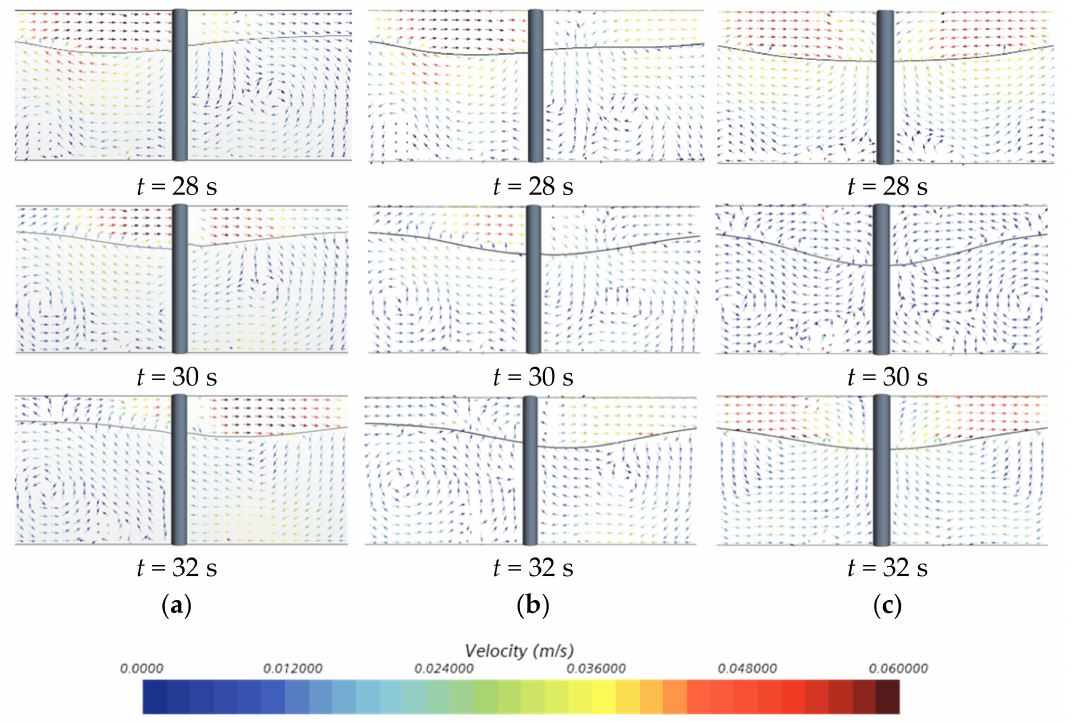
Figure 10. Velocity section of the flow field for ( a ) working condition 1; ( b ) working condition 3; and ( c ) working condition